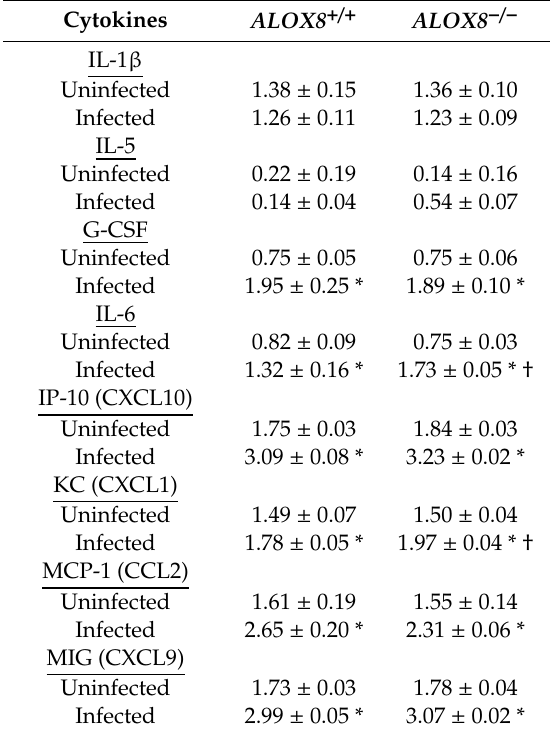
mice at 10 days after inoculation with influenza